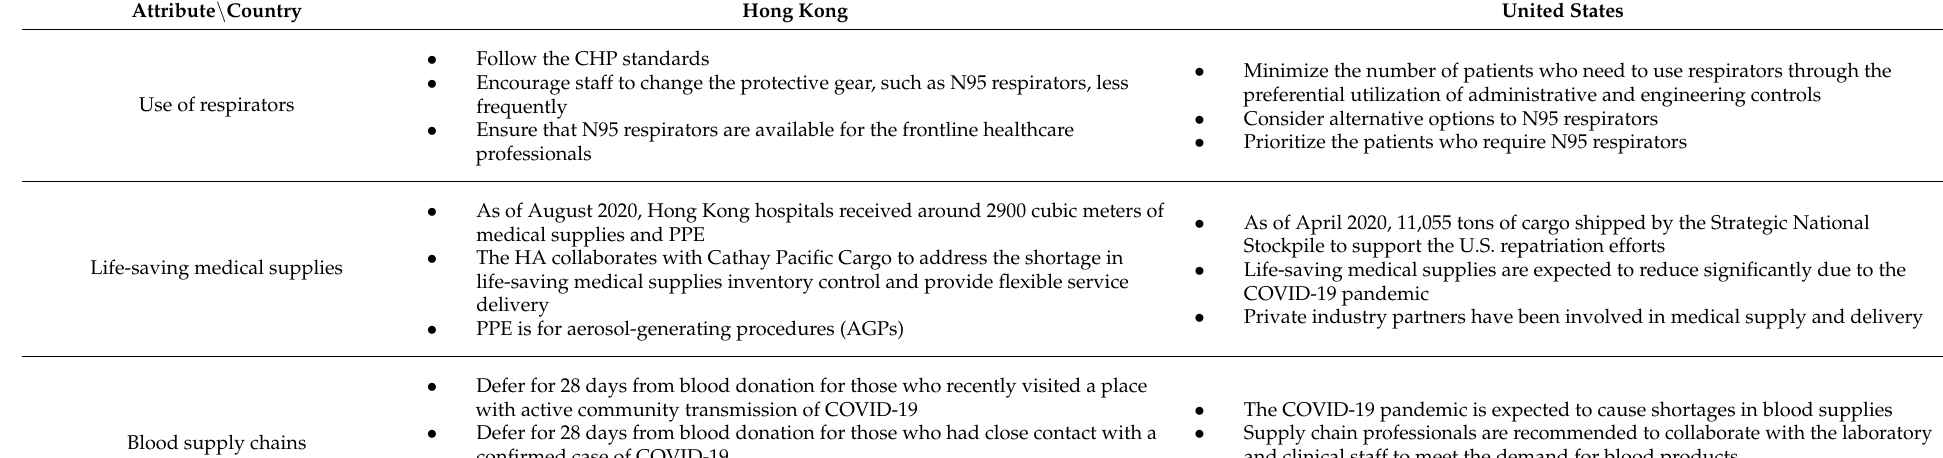
Table 1. Summary of the healthcare supply chain management trends in Hong Kong and the United States under the COVID-19 settings. Attribute \